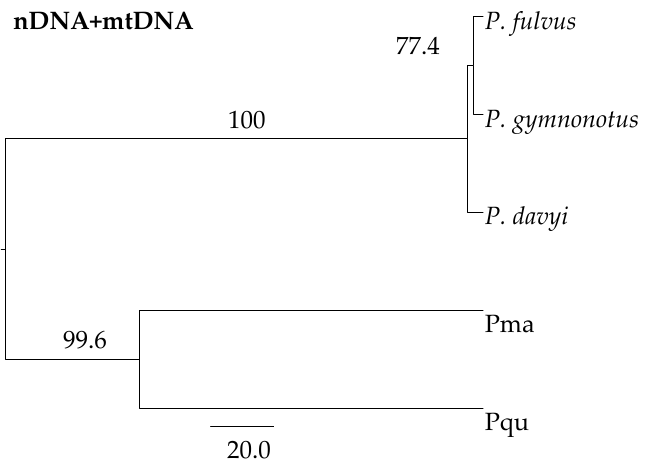
Figure 3. Species tree generated in *BEAST with nDNA and DNAmt. Support values (Pp) are given for each clade. P. macleayii (Pma) and P. quadridens (Pqu) were used as outgroups. See text for details of the analysis.